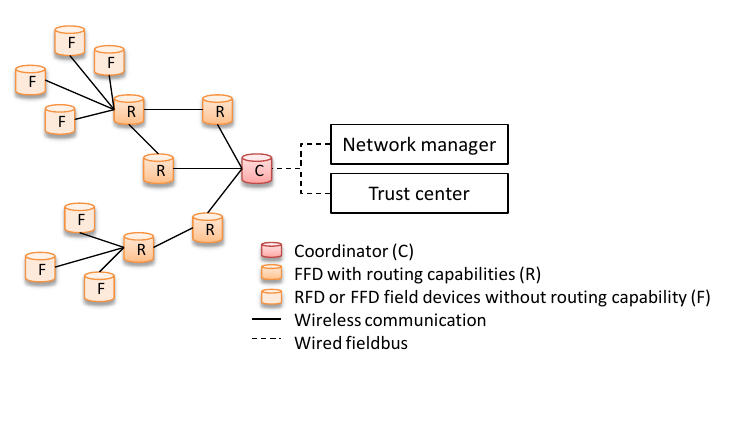
Figure 8. ZigBee network elements